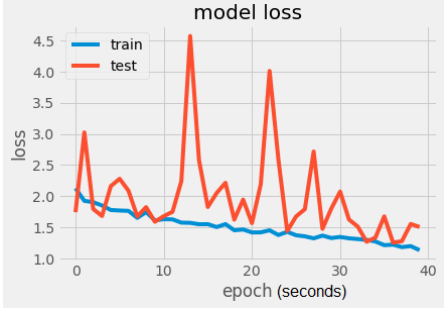
Figure 13. ResNet50 model loss.